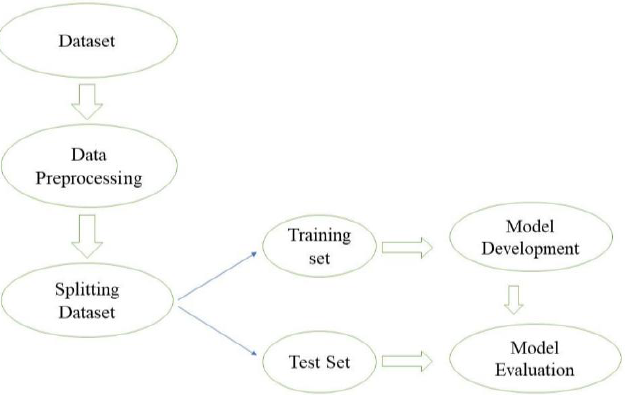
Figure 1. Simple illustration of various steps in the deployment of the ML process.